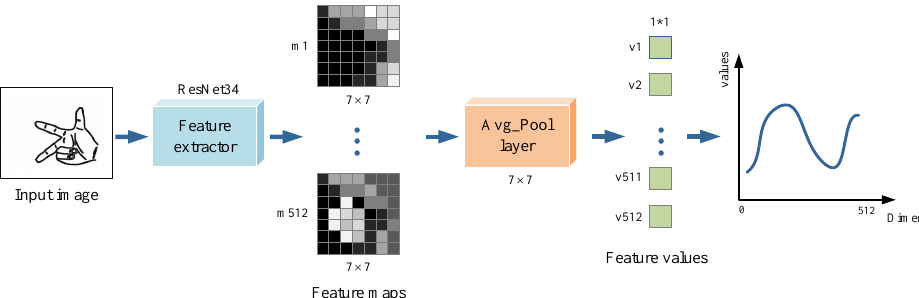
Figure 5. Hand image feature extraction based on